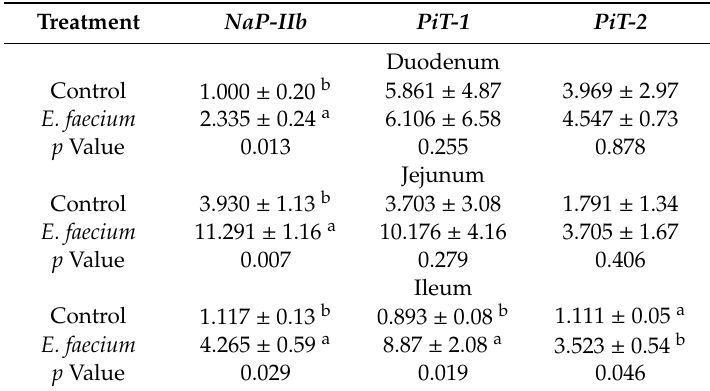
Table 6. Dietary E. faecium supplementation and NaP-IIb and PiT-1, 2 mRNA expression in small intestinal segments of